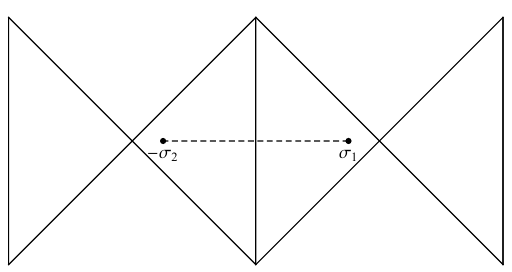
Figure 7. The doubled spacetime used to compute the bulk matter entropy. The boundary at the center of the figure is transparent. The left-most boundary and the right-most boundary are identified. σ 1 and − σ 2 denote twist operators inserted in the first and second copies of the black